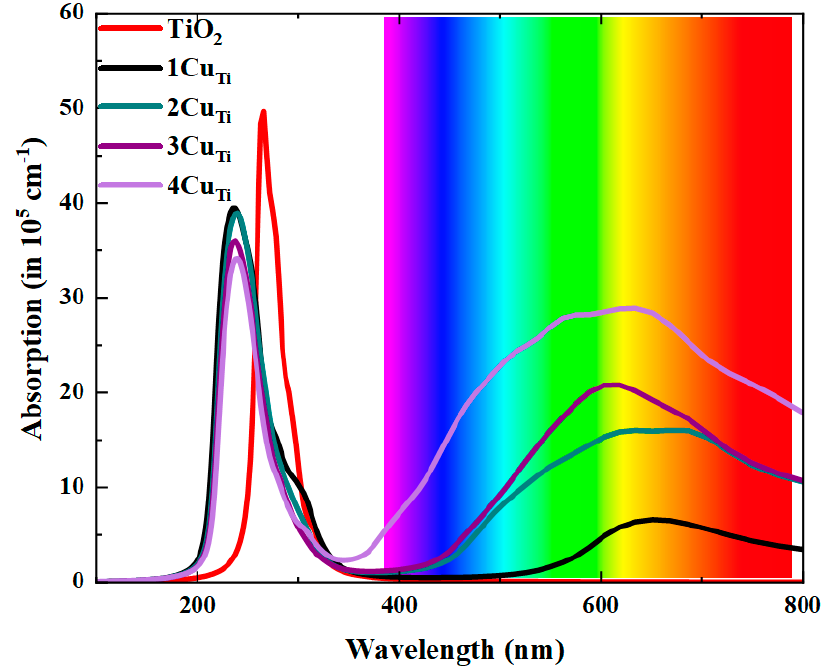
Figure 4. Computed optical absorption coefficients of undoped and Cu-doped TiO 2 with different configurations at the HSE06 level.